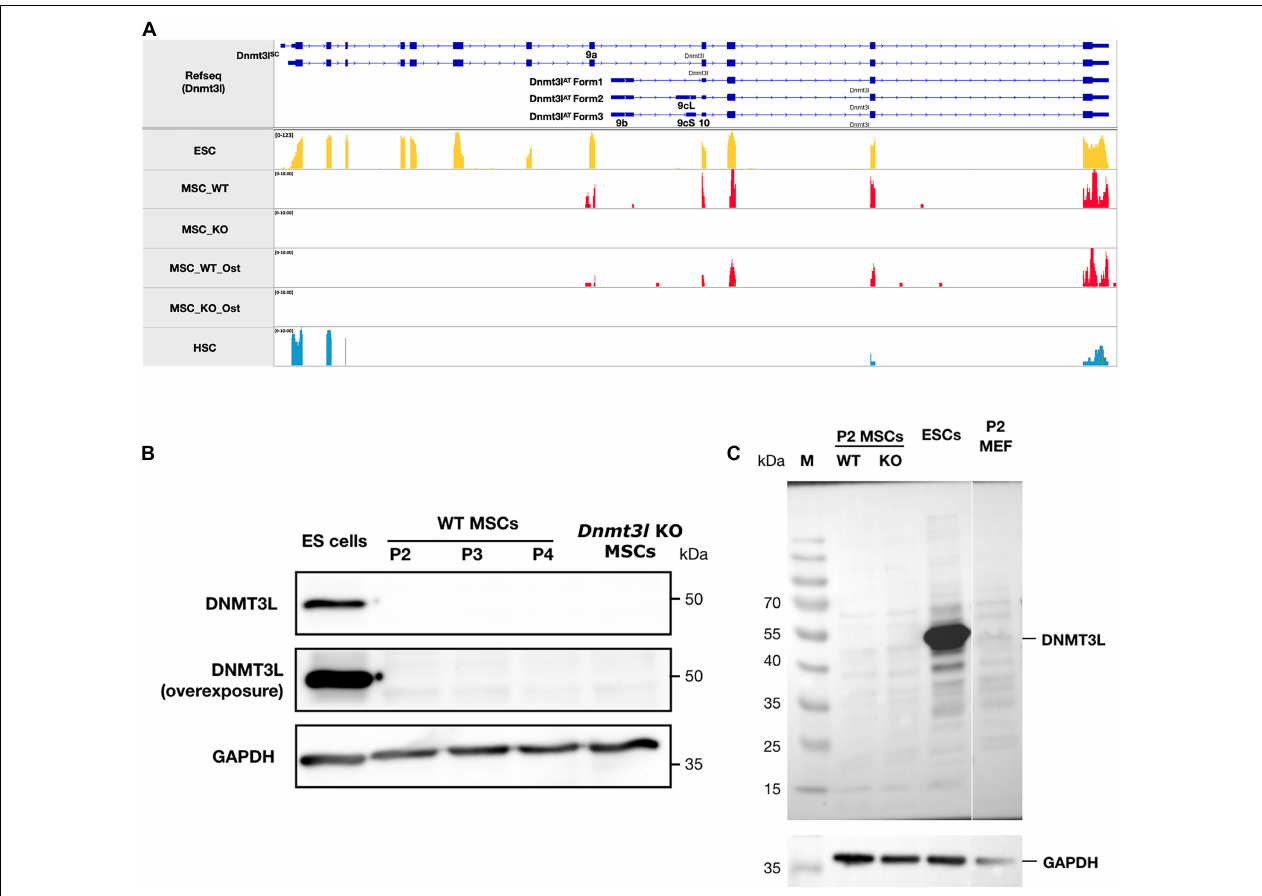
FIGURE 2 | The ∼ 50 kDa canonical stem cell form of DNMT3L protein is not detectable in MSCs. (A) No sequencing reads were mapped to exons 1–8 of Dnmt3l suggesting no canonical ∼ 50 kDa DNMT3L expression in MSCs. However, a potential novel isoform of Dnmt3l transcript starting from exon 9a can be observed to be expressed in low level in wild type but not Dnmt3l KO mice derived BM-MSCs. In contrast, 3 Dnmt3l isoforms that were described in adult testes previously all starting from exon 9b. (B) The canonical stem cell form of ∼ 50 kDa DNMT3L expression is highly expressed in ES cells detected by Western blotting. However, even under overexposure, there were no detectable DNMT3L signals at early passage (P2, P3, and P4) of MSCs. (C) Possibility of small DNMT3L (estimated to be 126 AA of around 20 kDa) expression has not been excluded but no distinct bands may be observed from our Western analysis of the MSC